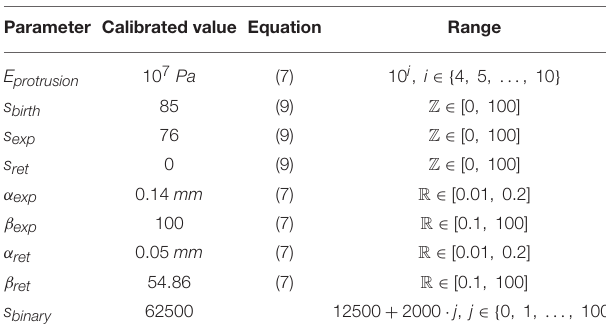
TABLE 5 | Model parameters calibrated using Bayesian optimization with